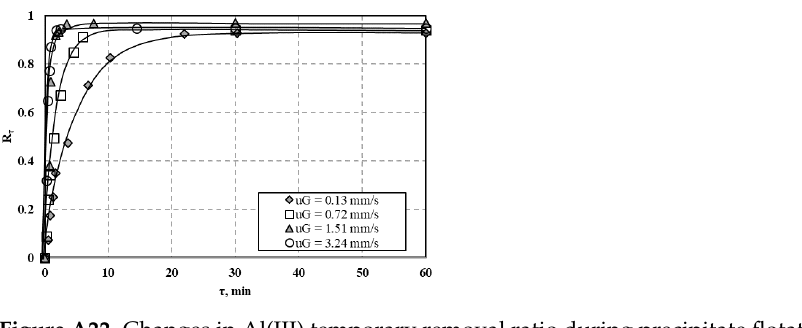
Figure A22. Changes in Al(III) temporary removal ratio during precipitate flotation from solution containing Al(III), Cu(II), and Zn(II) mixture—effect of air velocity (c 0 = 0.15 mmol dm − 3 , pH = 8.0, c SDS = 0.125 mmol dm − 3 ).